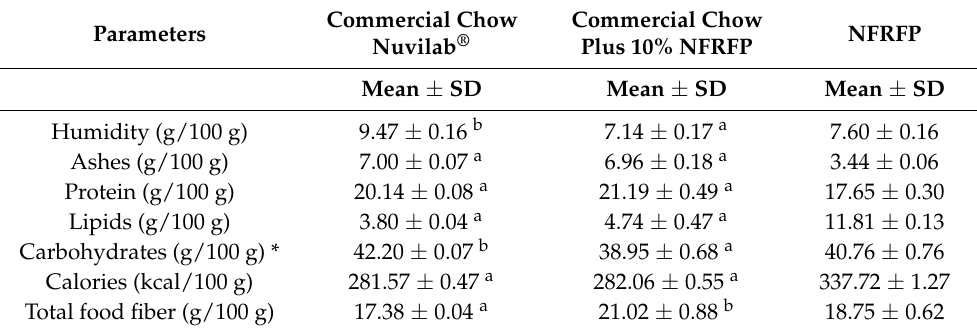
Table 1. Chemical analysis of commercial chow, chow plus 10% NFRFP and